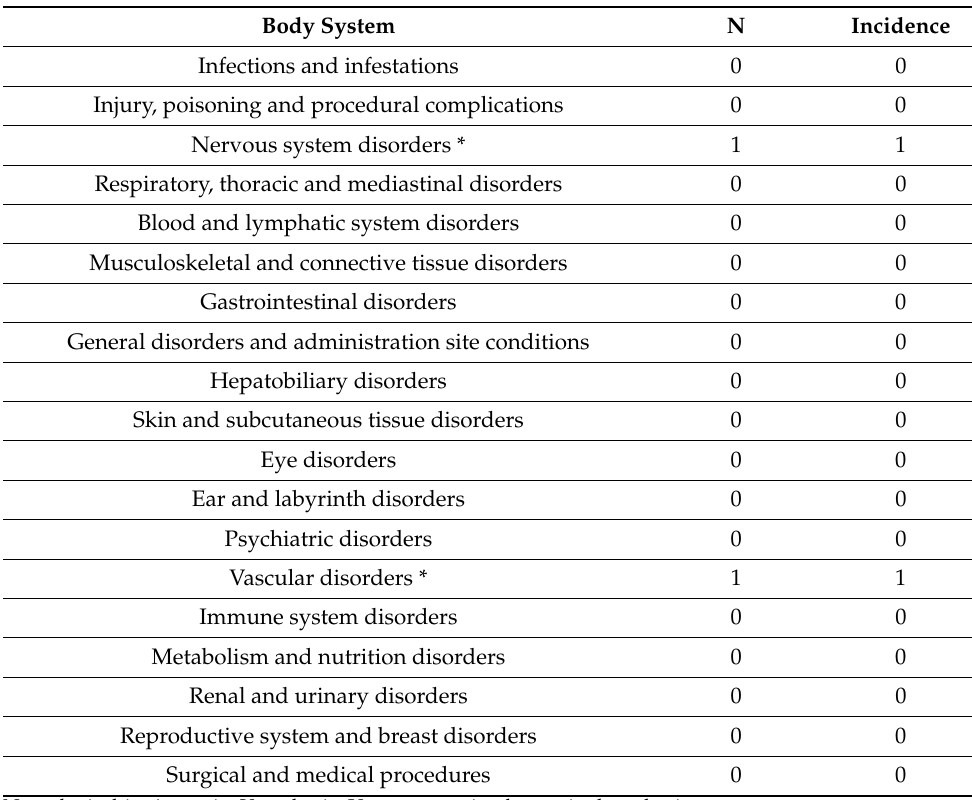
Table 7. Adverse Events: Frequent and/or Serious.